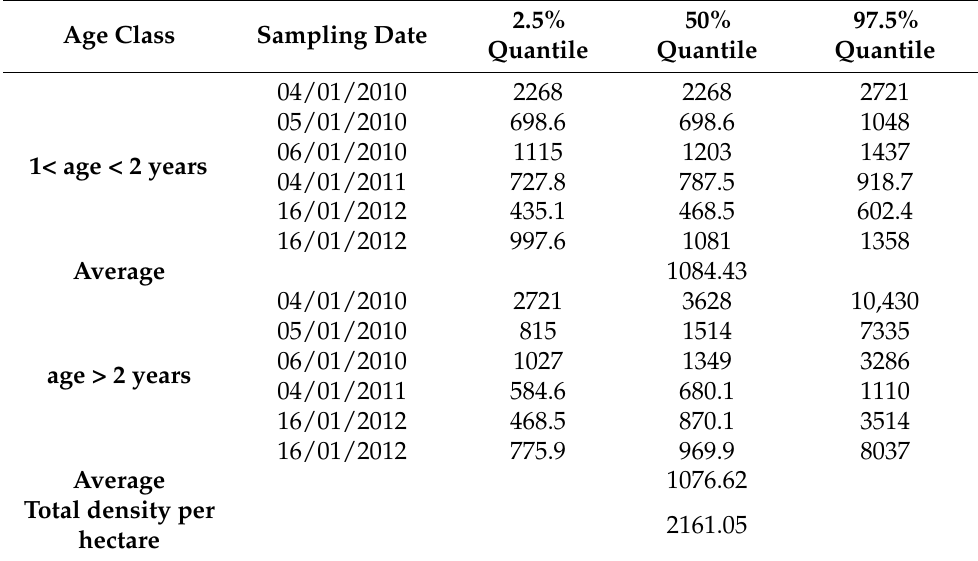
Table A4. Density Estimates for the Val Travers population. The density estimates are provided as the number of fish per hectare. Three different sites were selected and sampled in 2010, and were all revisited for sampling in 2011 and